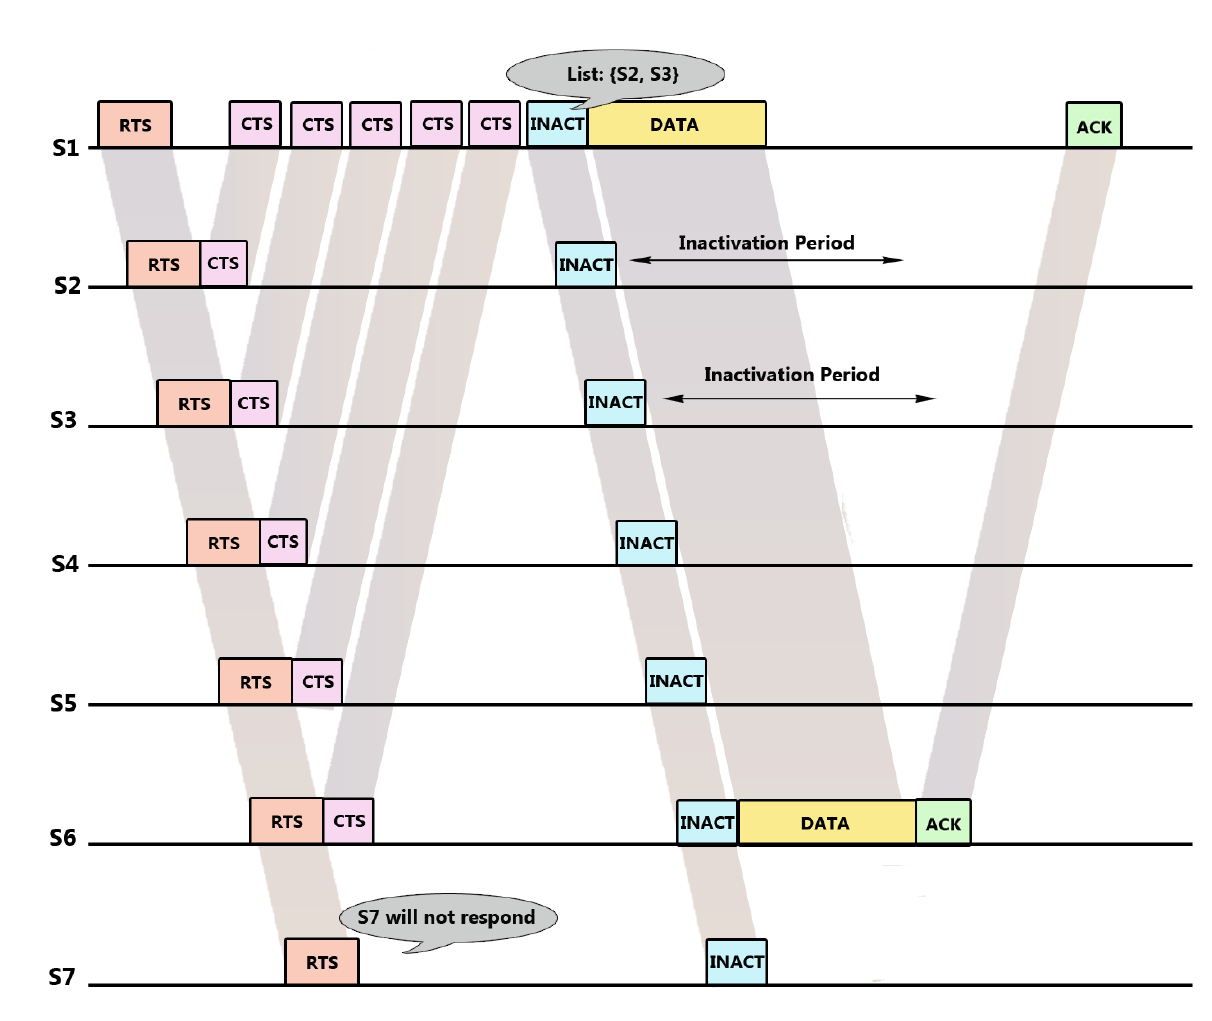
Figure 6. Timeline indicates the exchanging of